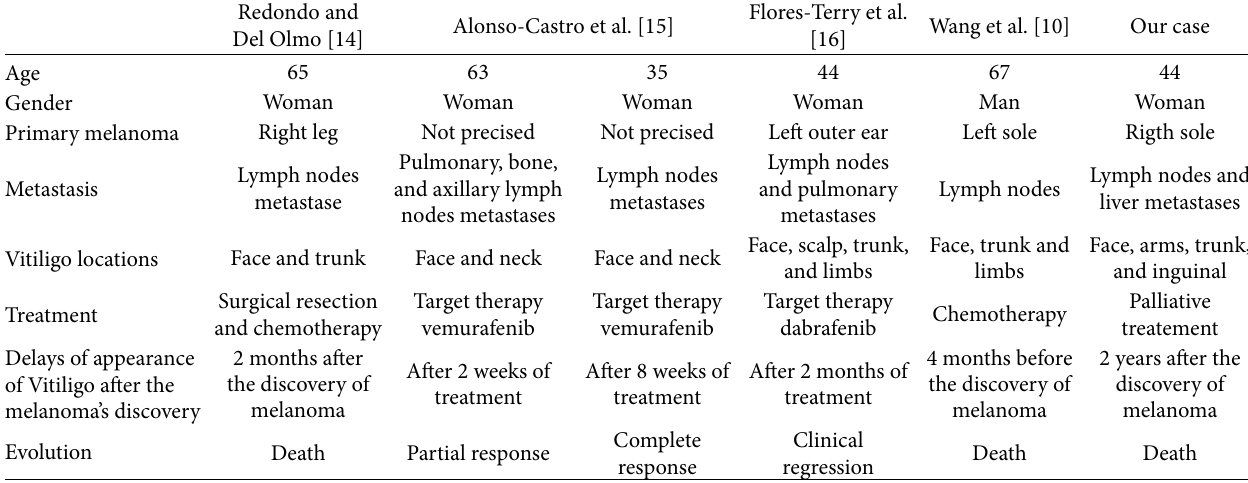
1: Comparative analysis of some cases of melanoma associated with Vitiligo reported in the